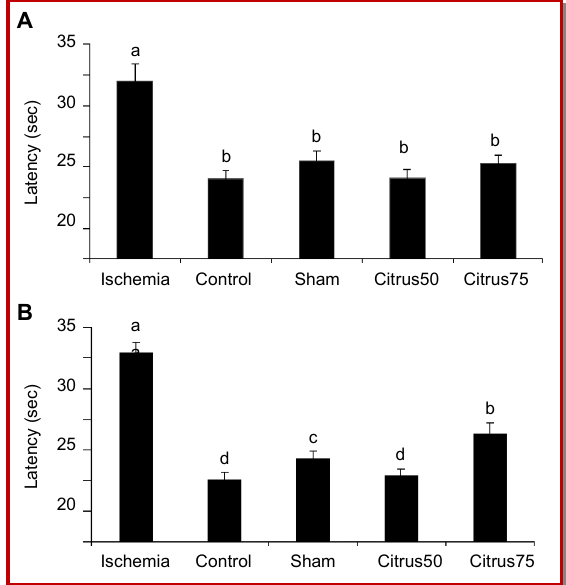
Figure 2 : Comparison of the latency to find the platform on day 3 (A) and day 4 (B) between ischemia group and other groups. Similar letters represent no significant difference and dissimilar letters represent significant difference (p <0.05) ( Citrus75 and Citrus50: treated with 75 and 50 mg/ kg of C. aurantium essential oil, respectively